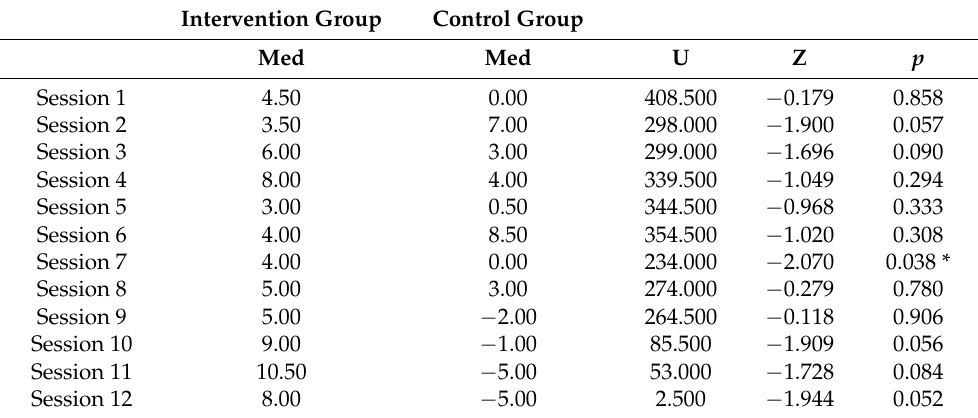
Table 5. Mean pre- and post-intervention differences in systolic blood pressure behavior over 12 progressive muscle relaxation sessions for the intervention and control group athletes and p -value resulting from the comparison with the Mann–Whitney